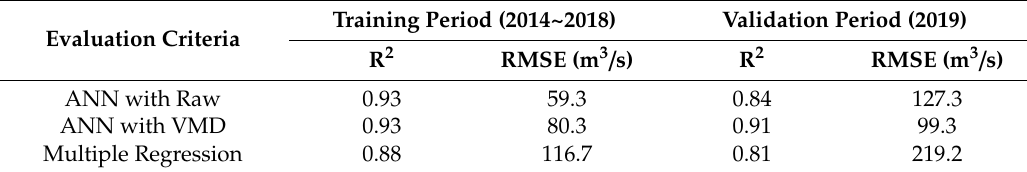
Figure 6. Simulated result with two ANN models: ( a ) learning periods, ( b ) validation periods; black line indicates observed runoff, green line indicates simulated runoff with multiple regression, blue line indicates simulated runoff with raw runoff, and red line indicates simulated runoff with modes and residual. Table 2. Evaluation criteria for ANN model result using VMD and raw runo ff